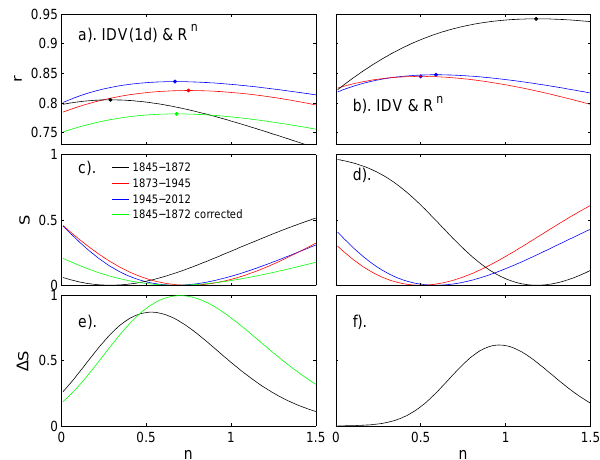
Fig. 1. The dependence of the IDV(1d) (corrected and corrected, left panels) and IDV (right panels) on international sunspot num- ber, R , to the power n , as a function of the exponent n . (a) and (b) show the correlation coefficients for the interval 1845–1872 (black line), 1873–1945 (red line) and 1946–2012 (blue line). In the case of IDV(1d) the black line is uncorrected and the green line shows the effect of implementing the correction derived in the present paper. The coloured circle indicates the peak of each correlogram. (c) and (d) , the significance S of the differences between the peak correla- tions and those at general n . (e) and (f) , the probability 1S that the dependence on R before 1872 is the same as after that date (see text for